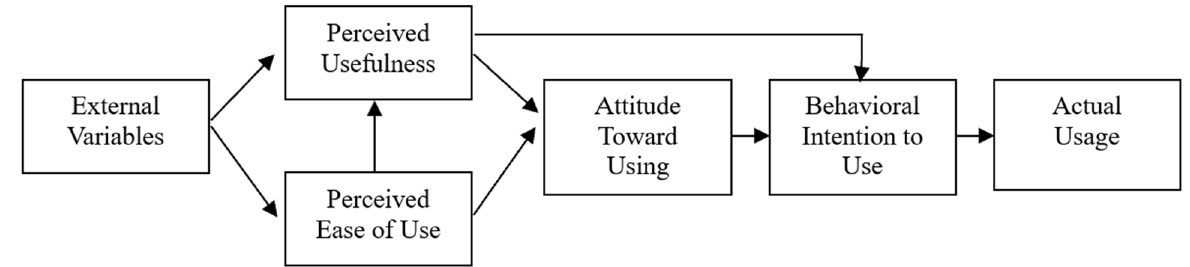
Figure 1. The structure of TAM (drawn via this research by referencing Davis’s (1989) Technology Acceptance Model). Acceptance Model)